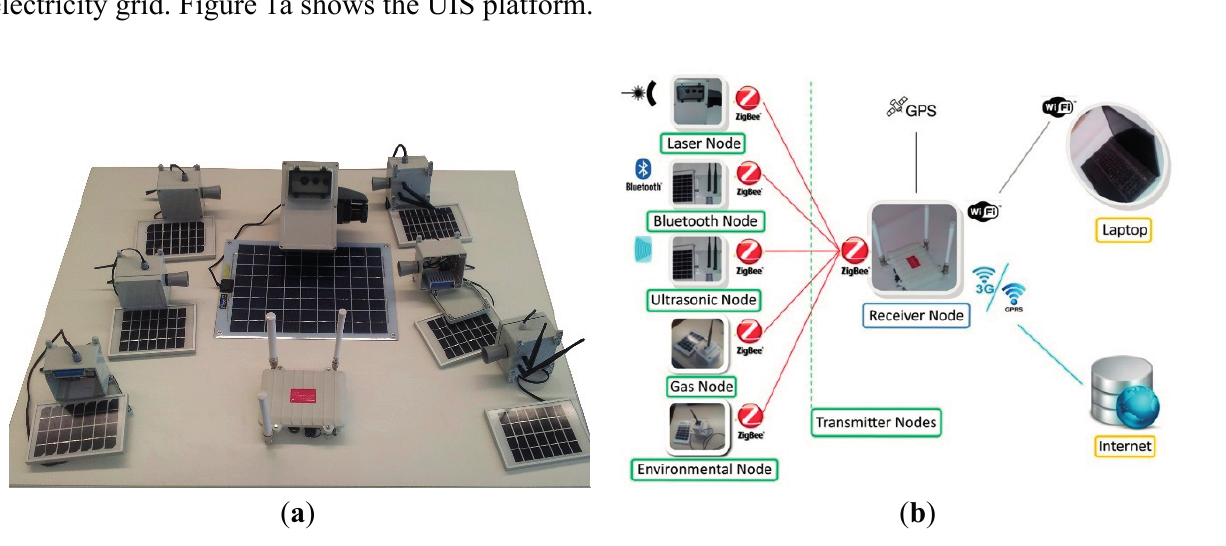
Figure 1. UIS platform. ( a ) General overview of some nodes; ( b )